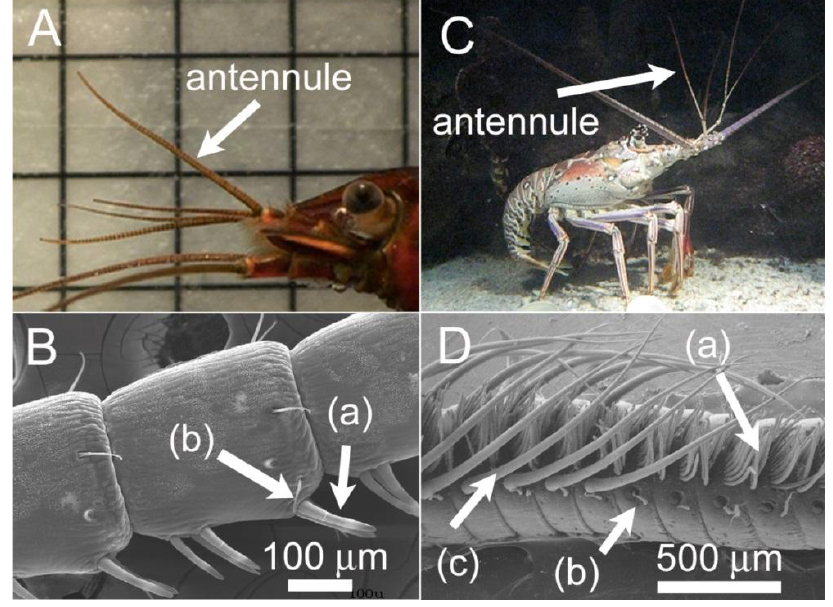
Figure 1. ( A ) The freshwater crayfish, Procambarus clarkii , with lateral antennule labeled. Grid in the background is 1  1 cm; ( B ) Scanning electron micrograph (SEM) of the lateral antennule with (a) chemosensory aesthetascs and (b) mechanosensory sensilla labeled (photo D. Mellon); ( C ) The spiny lobster, Panulirus argus , with the lateral antennule labeled; ( D ) SEM of the lateral antennule with (a) chemosensory